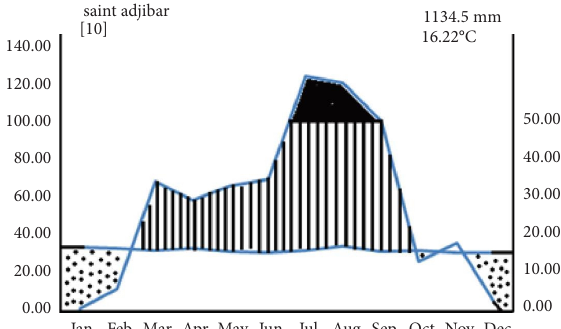
Figure 2: Climadiagram of the study area (2009–2018) (data source: